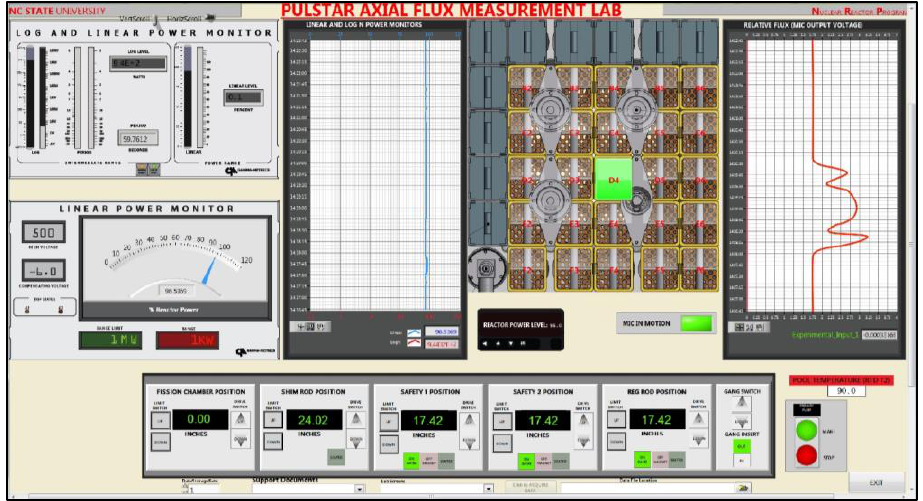
Fig. 7. Axial Flux Measurement Laboratory GUI; note the position of the dry well highlighted in green in fuel assembly D4, and the detector current trace at